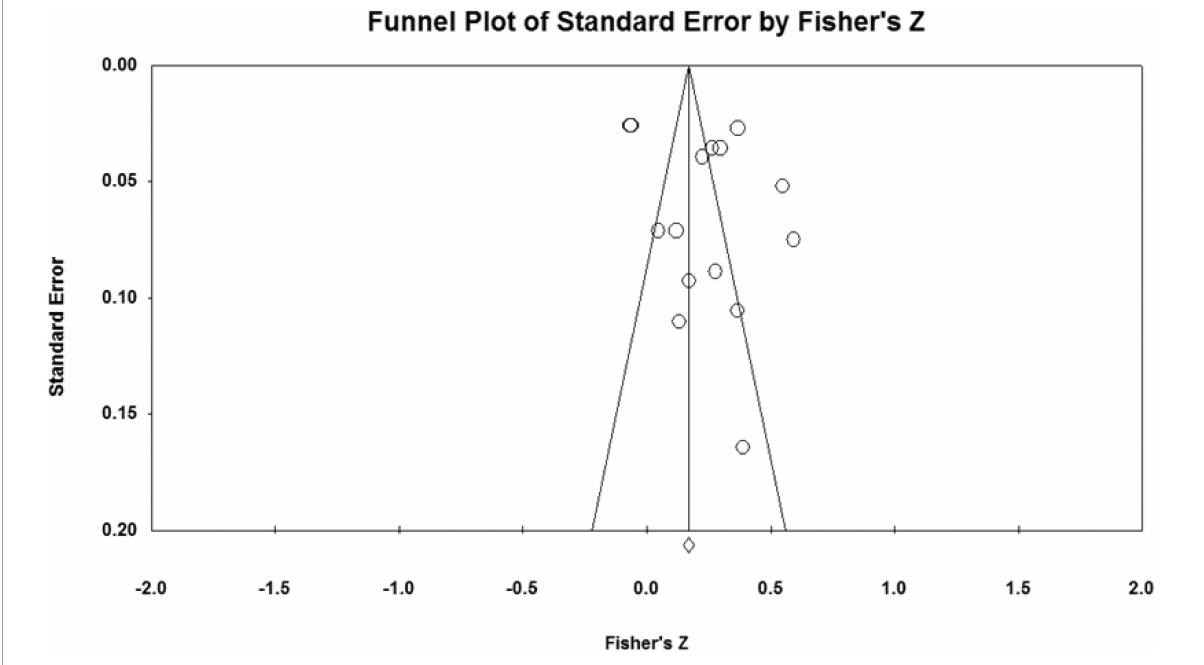
FIGURE3 Funnel plot of the relationship between authoritarian parenting and sibling conflicts studies.